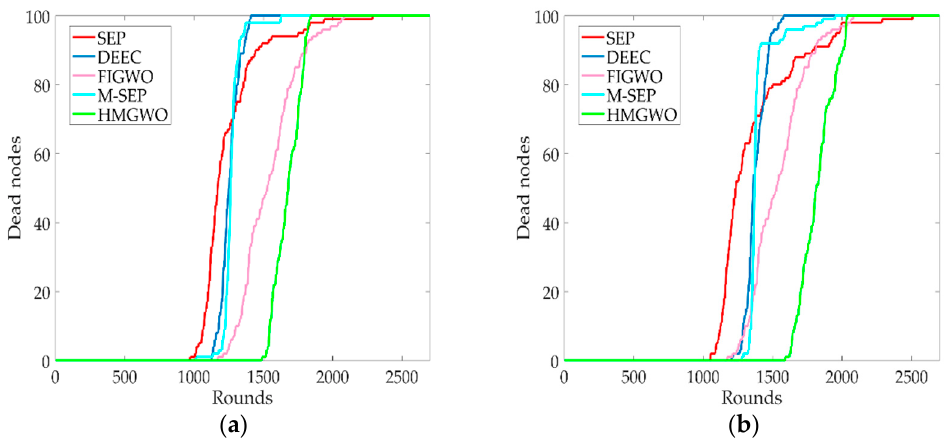
Figure 2. Network stability period with respect to the number of rounds. ( a ) The ratio of the advanced node is 0.1, and the HMGWO network stability period is compared with SEP, DEEC, M-SEP, and FIGWO; ( b ) The ratio of the advanced node is 0.2, and the network stability period of HMGWO relative to SEP, DEEC, M-SEP, and FIGWO.